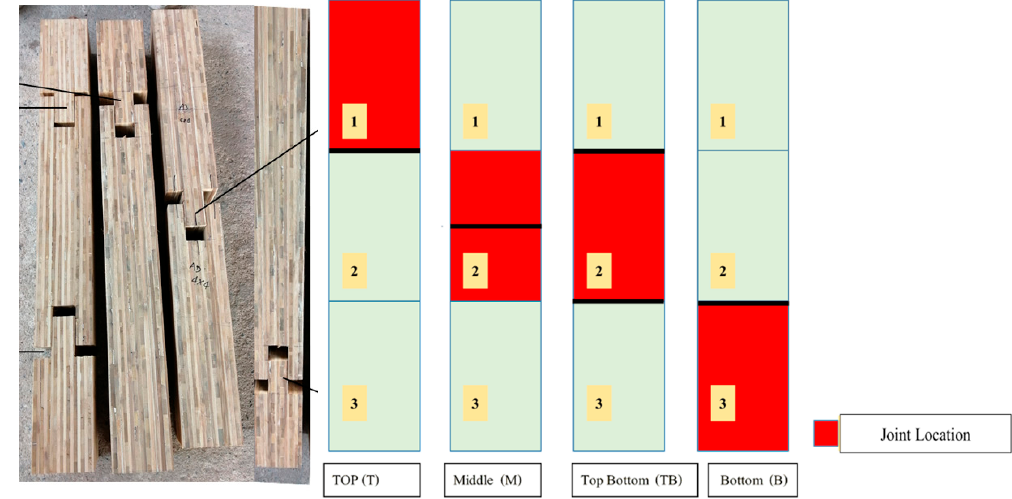
Figure 3. The location of connection.